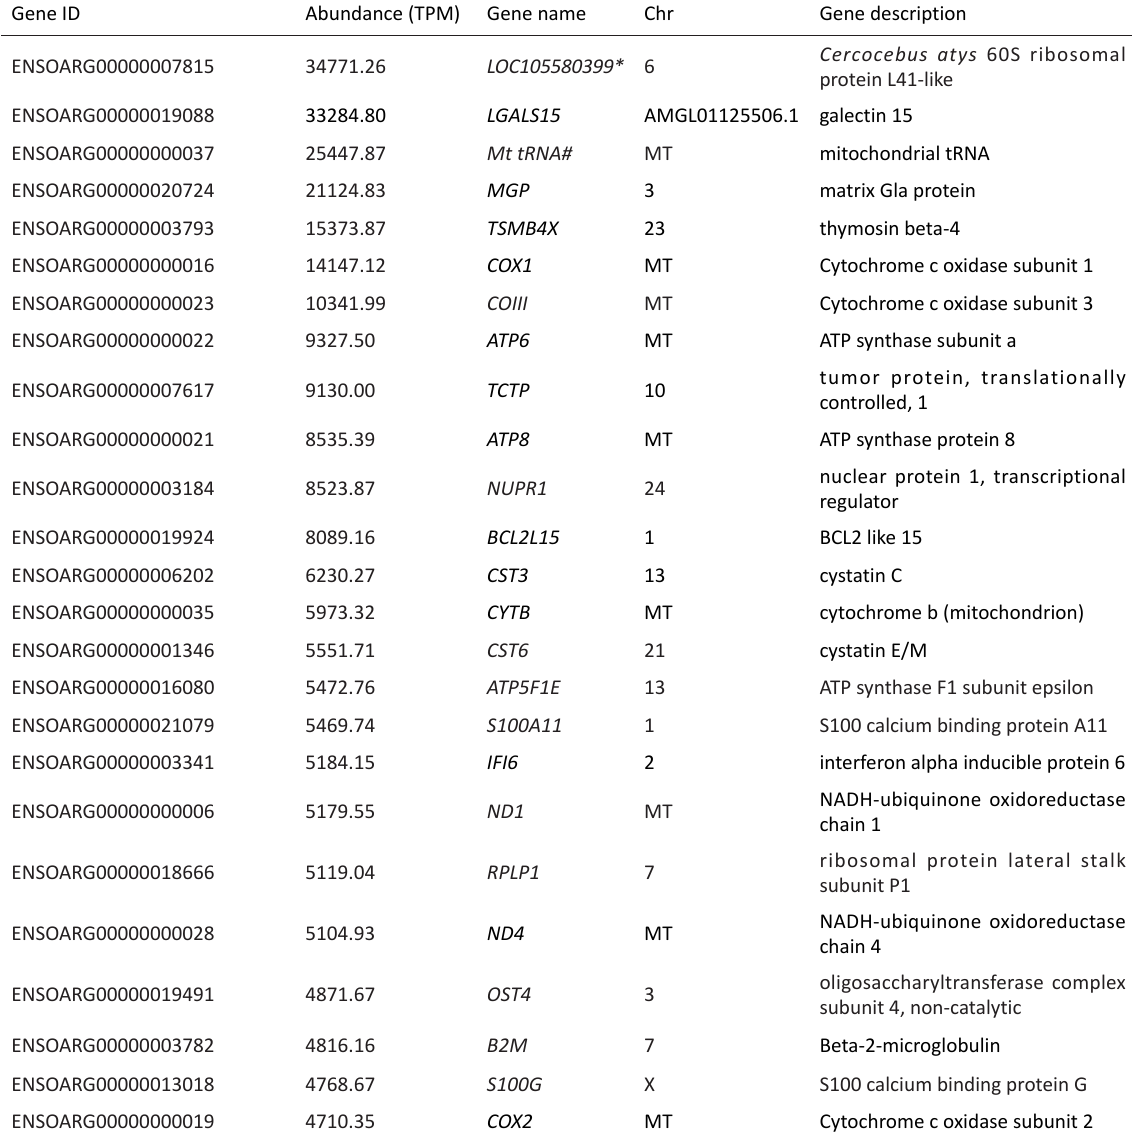
Table 2. List of the 25 most abundant genes in the endometrium. The table includes the Ensembl gene ID (GeneID), abundance measured by number of transcripts per million reads (TPM), chromosome number (Chr; MT refers to mitochondrial genome and AMGL01125506.1 is an unplaced scaffold), and gene description. Gene IDs and annotations that were not available in BioMart were retrieved based on a homology search using the nucleotide BLAST (marked with an asterisk, “*”) or on information available in Ensembl (marked with a hash,